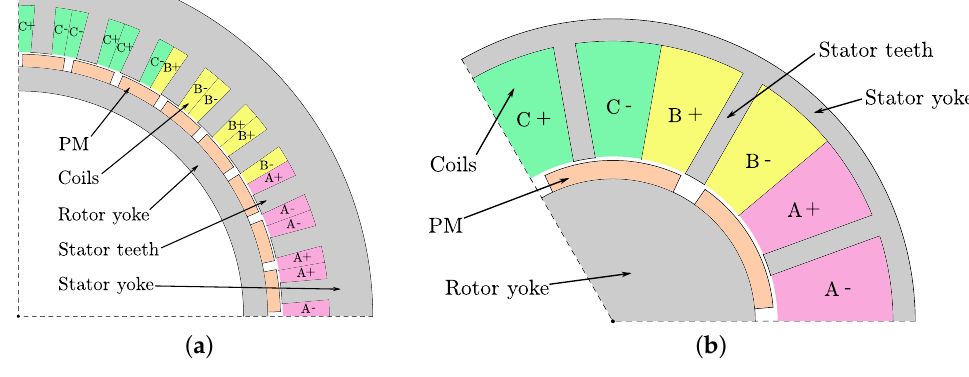
Figure 12. Machine topology: ( a ) Machine I. ( b ) Machine II.